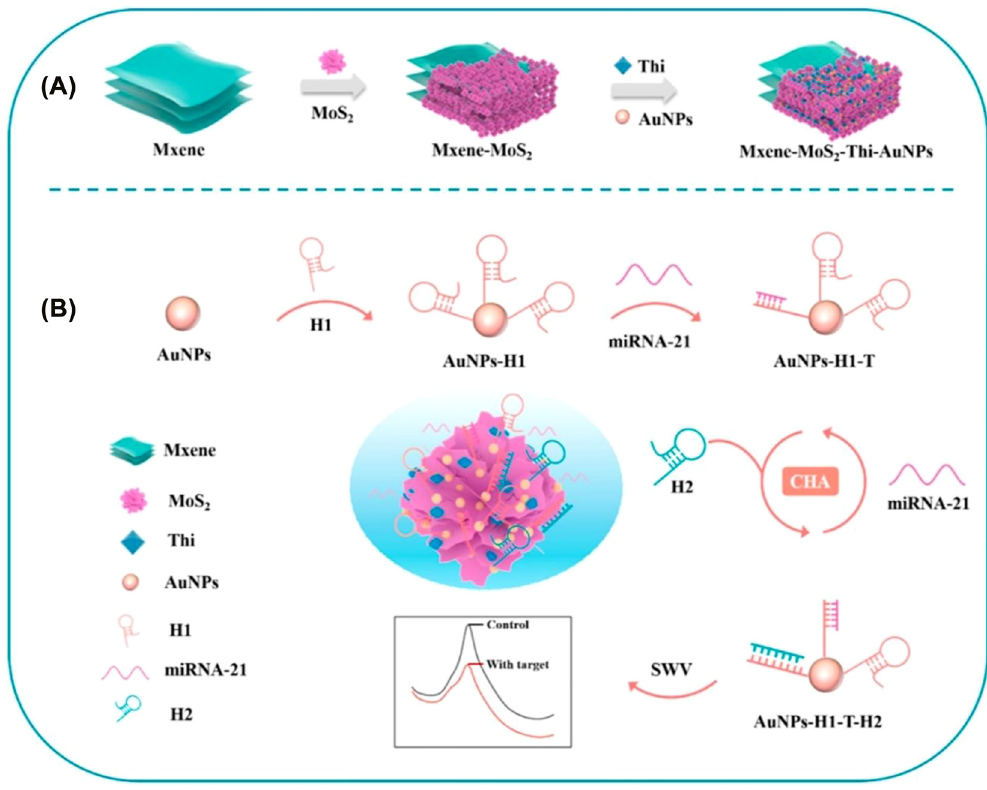
nanostructure enhancing electrochemical biosensor for label-free detection of Figure 6: Schematic illustration of the MXene-MoS 2 microRNA-21. Reproduced with permission from [238] Copyright @ Elsevier